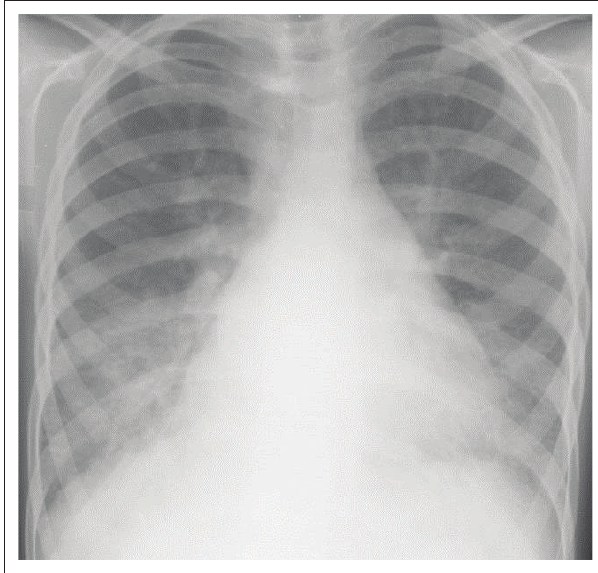
FIGURE 5: Chest x-ray of the